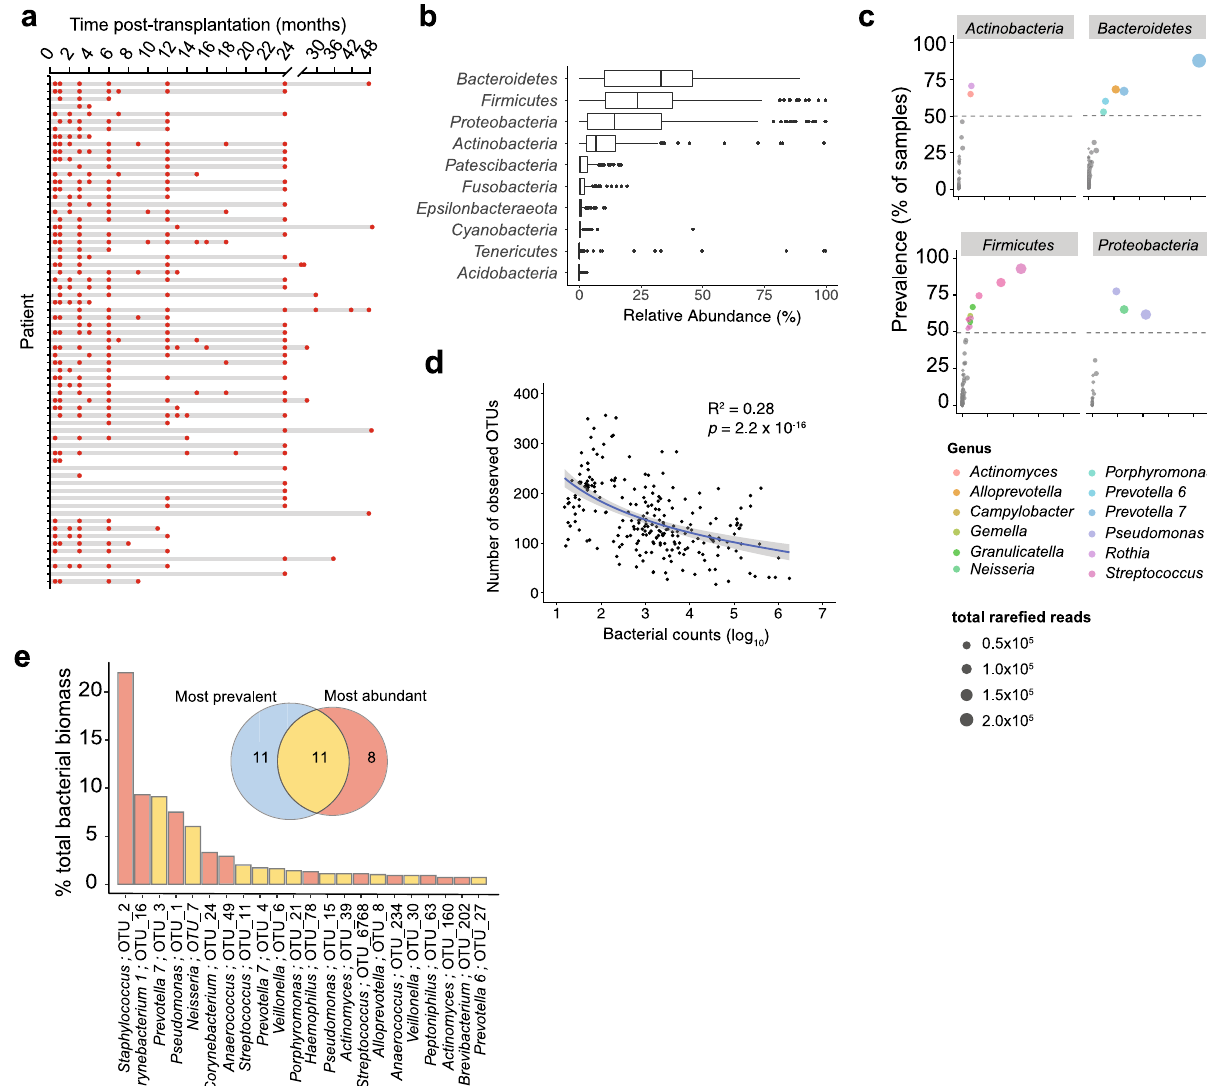
Fig. 1 Combining BALF amplicon sequencing and bacterial culturing to deduce the microbial ecology of deep lung microbiota. a Schematic of the sampling of Bronchoalveolar lavage fl uid (BALF) from lung transplant recipients over time (months post-transplant). b Relative abundances (%) of most abundant phyla across BALF samples. Box plots show median (middle line), 25th, 75th percentile (box) and 5th and 95th percentile (whiskers) as well as outliers (single points). c Prevalence (% samples) vs contribution to total reads across samples for most abundant phyla. Dot color shows different genera and size show total rare fi ed reads. Gray dashed horizontal line shows prevalence ≥ 50%. d Scatter plot shows correlation between number of observed OTUs and bacterial counts per BALF sample obtained by quantifying 16S rRNA gene copies with qPCR. Linear regression is shown by the blue line with gray shaded area showing 95% con fi dence interval ( n = 234, two-sided, F (1, 232) = 91.04, P = 2.2 × 10 − 16 ), Coef fi cient of correlation; R 2 = 0.28. e Bar chart shows lung taxa (genera; OTU IDs) that contributed ≥ 75% of total bacterial biomass across samples ( n = 234). Venn diagram inset shows overlap (yellow) between the most prevalent ( ≥ 50% incidence, light blue) and the most abundant ( ≥ 75% total count, red) taxa in the transplanted lung. Bar colors also show the